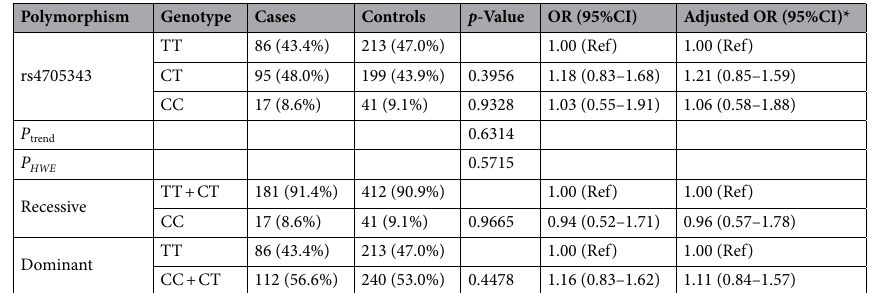
Table 3. Distributions of rs4705343 genotypic frequencies between asthmatic patient and control groups. p- values were calculated by Chi-square without Yates’ correction. P trend p -value for trend, P HWE p -value for Hardy–Weinberg equilibrium. *Adjusted for age, gender, and smoking status.